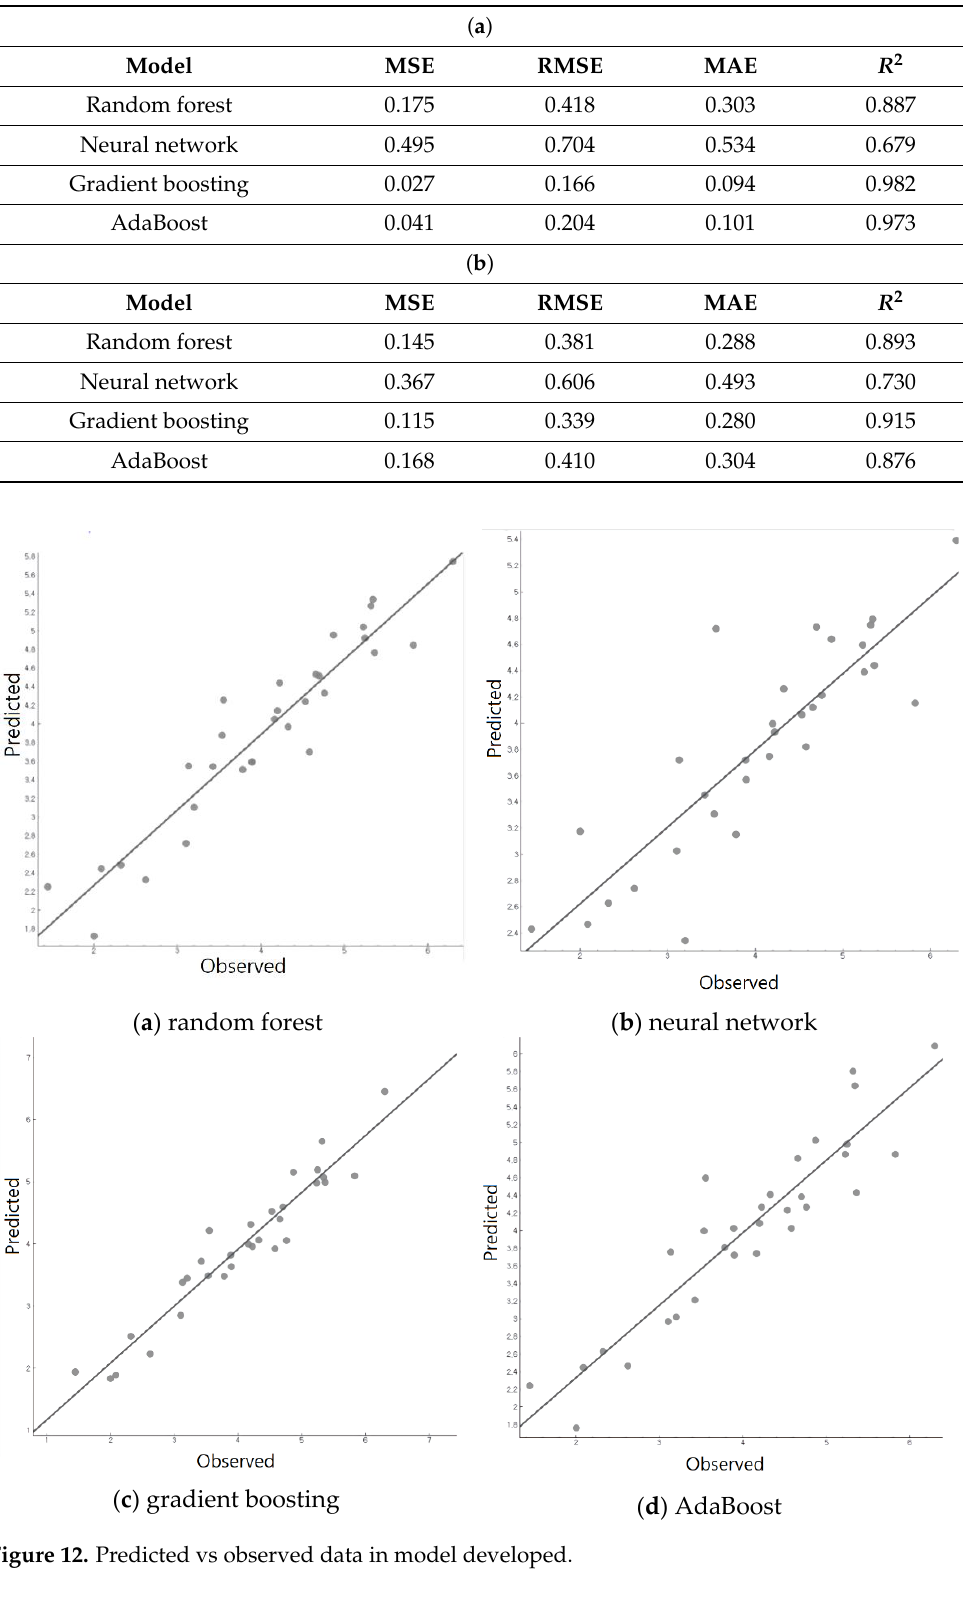
Figure 13. R 2 value (training vs. testing). 6.4. Sensitivity Analysis of ML Models